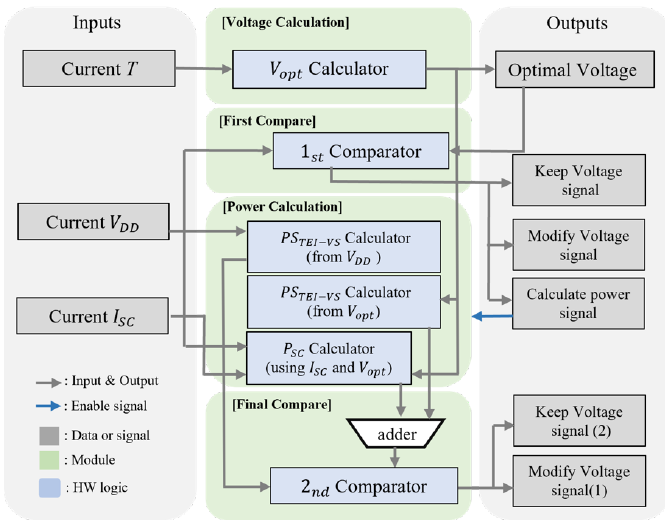
Figure 6. Diagram of the proposed PMIC control